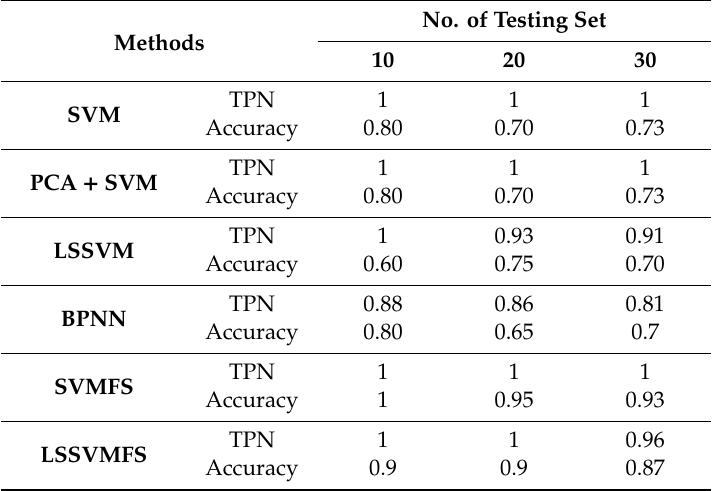
Table 6. Classification results for patent infringement